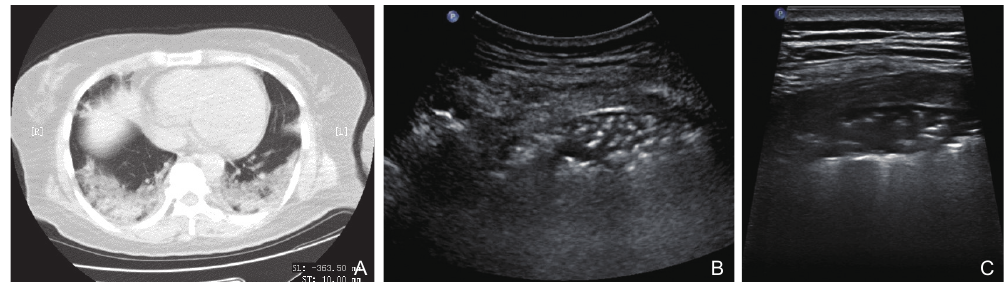
Figure 12 COVID-19 critical stage imaging performance. (A) 42-year-old female COVID-19 patient on the 13th day of fever with body temperature up to 38.5℃. CT showed widespread lung lesions, bilateral large laminar hypoechoic consolidation in posterior lung fields, and air bronchogram sign; (B and C) Ultrasound showed hypoechoic consolidation area with posterior fused